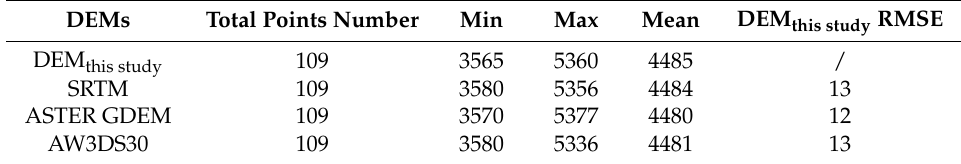
Comparisons of 109 points from glacier-free terrain from Advanced Spaceborne Thermal Emission and Reflection Radiometer (ASTER) Digital Elevation Model (DEM) mosaic with reference